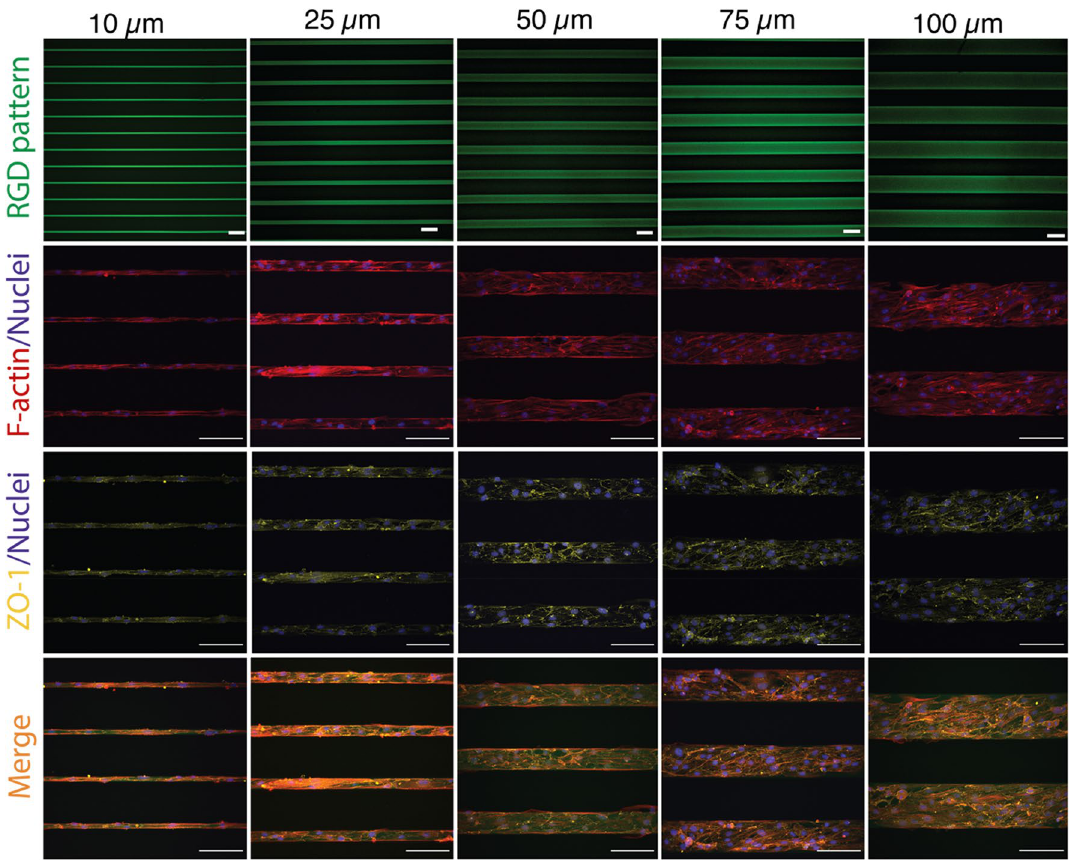
Figure 1. Brain microvascular endothelial cells adhere selectively to the RGD-patterned lines. First row: Lines of fluorescent 5-FAM-GCG YRG DSPG peptide patterned on HA-am hydrogels (green). Second row: b.End3 cells seeded on the lines stained for F-actin (red) and nucleus (blue). Third row: b.End3 cells seeded on the lines stained for zonula occludens-1 (ZO-1) (yellow) and nucleus (blue). Forth row: Merged images showing the cells on the micropatterned lines illustrating that the cells are adhering only to the peptide-patterned lines. Scale bars correspond to 100 µm in all